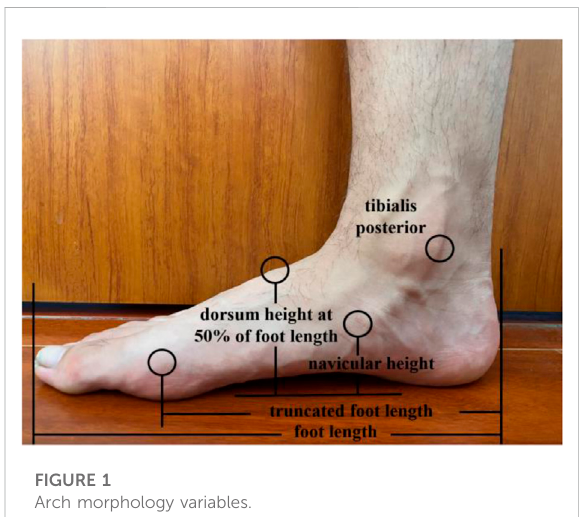
FIGURE 1 Arch morphology